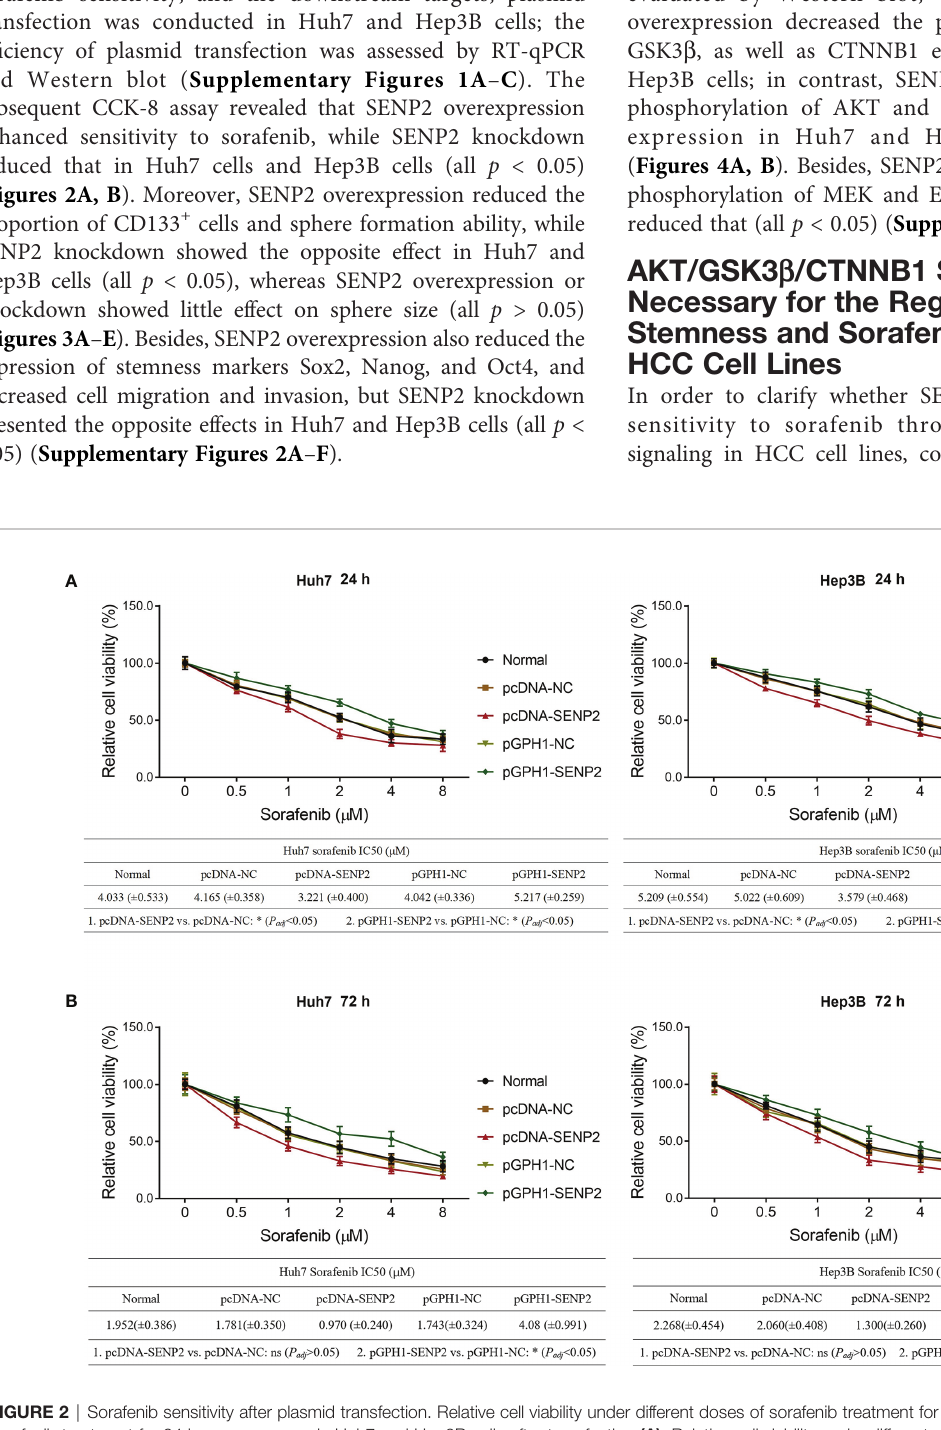
FIGURE 2 | Sorafenib sensitivity after plasmid transfection. Relative cell viability under different doses of sorafenib treatment for 24 h and comparison of IC 50 value of sorafenib treatment for 24 h among groups in Huh7 and Hep3B cells after transfection (A) . Relative cell viability under different doses of sorafenib treatment for 72 h and comparison of IC 50 of sorafenib treatment for 72 h among groups in Huh7 and Hep3B cells after transfection (B) . SENP2, Small ubiquitin-like modi fi er speci fi c peptidase 2; NC, negative control; IC 50 , half maximal inhibitory